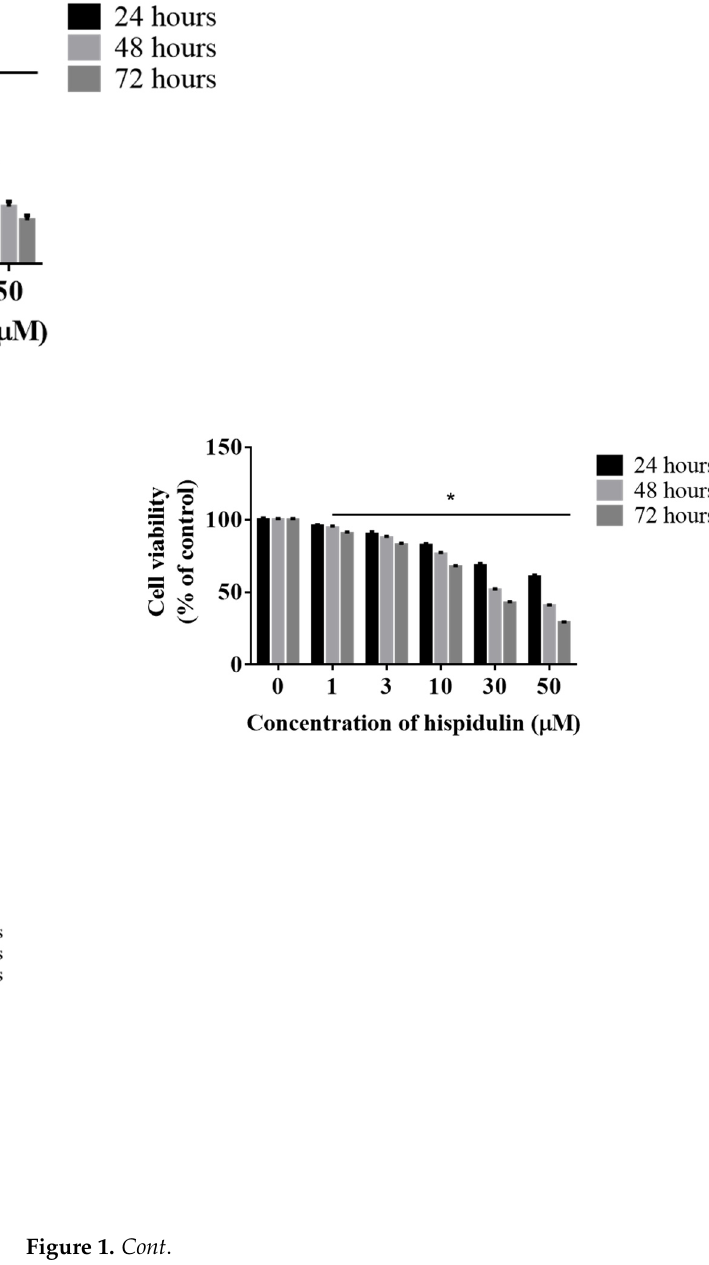
( E ) Figure 1. Cytotoxicity of hispidulin on A2058 cells, BCC cells, and keratinocytes. A2058 cells were treated with indicated concentrations (0, 1, 3, 10, 30, and 50 µM) of hispidulin for 24, 48, and 72 h, and cell survival was determined by the ( A ) MTT assay and ( B ) crystal violet assay. ( C ) BCC cells were treated with indicated concentrations (0, 10, 30, and 50 µM) of hispidulin for 24, 48, and 72 h, and cell survival was determined by the MTT assay. ( D , E ) Two kinds of keratinocytes (HaCaT and NHEKs) were treated with indicated concentrations (0, 1, 3, 10, 30, and 50 µM) of hispidulin for 24, 48, and 72 h, and cell survival were determined by the MTT assay. Data are presented as percentage of control and mean ± SE. * p < 0.05 compared with the untreated control group (n = 5). 3.2. Hispidulin Promoted Cell Cycle Arrest in A2058 Melanoma Cells Previous studies have indicated that hispidulin can cause the G0/G1 phase cell cycle arrest in human renal cell carcinoma, glioblastoma, liver cancer, gallbladder cancer, and acute myeloid leukemia [16,18,20,24,25]. In gastric cancer, it is arrested in G1/S phase [26]. In order to further explore the mechanism of hispidulin inhibiting cell growth, the cell cycle distribution of A2058 cells treated with hispidulin was analyzed. The cell cycle was analyzed by flow cytometry. Compared with the control group, the number of cells in the G0/G1 phase decreased with the increase of hispidulin concentration, and accumulated in the S or G2/M phase (Figure 2A,B). Cyclin D1 plays a regulatory role in the transition from G1 to G1/S. The effect of hispidulin on the performance of cyclin D1 was further evaluated. The results show that the effect of hispidulin will reduce the expression of cyclin D1 in A2058 cells in a dose-dependent manner (Figure 2C). These results indicated that cyclin D1 is involved in hispidulin-mediated cell cycle arrest events.